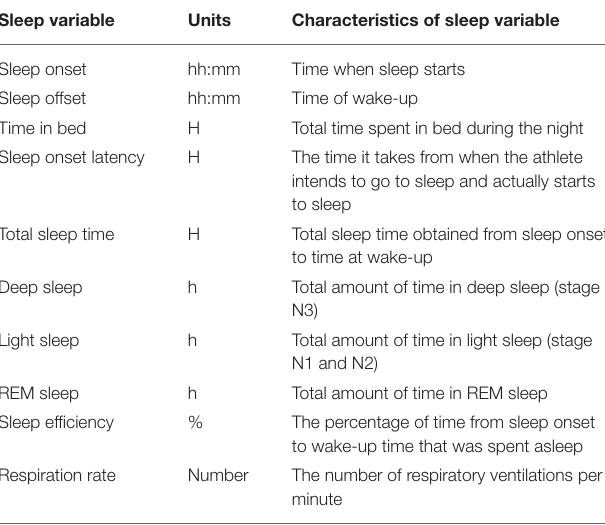
TABLE 1 | Complete list of sleep variables derived from the sleep algorithm used in the sleep monitor. Sleep variable